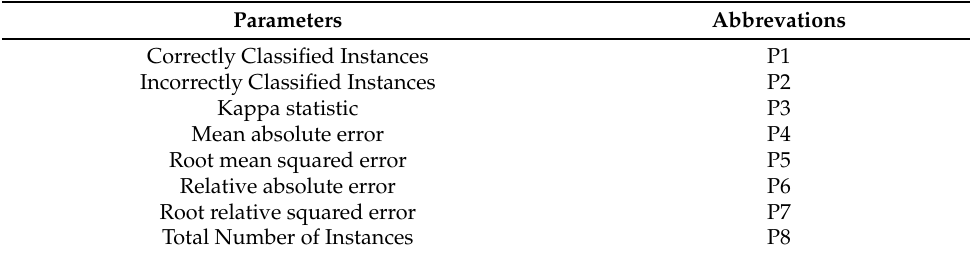
Table 2. Different types of the parameters